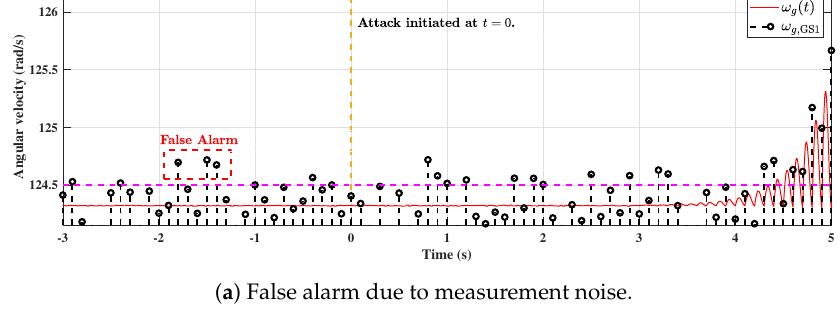
( a ) False alarm due to measurement noise.